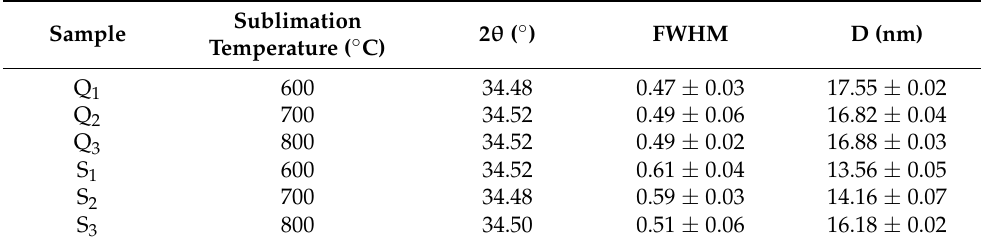
Table 1. Summary of the structural characteristics of ZnO obtained from the XRD patterns—(002) plane—of the ZnO films formed on quartz and Si substrates and processed at different